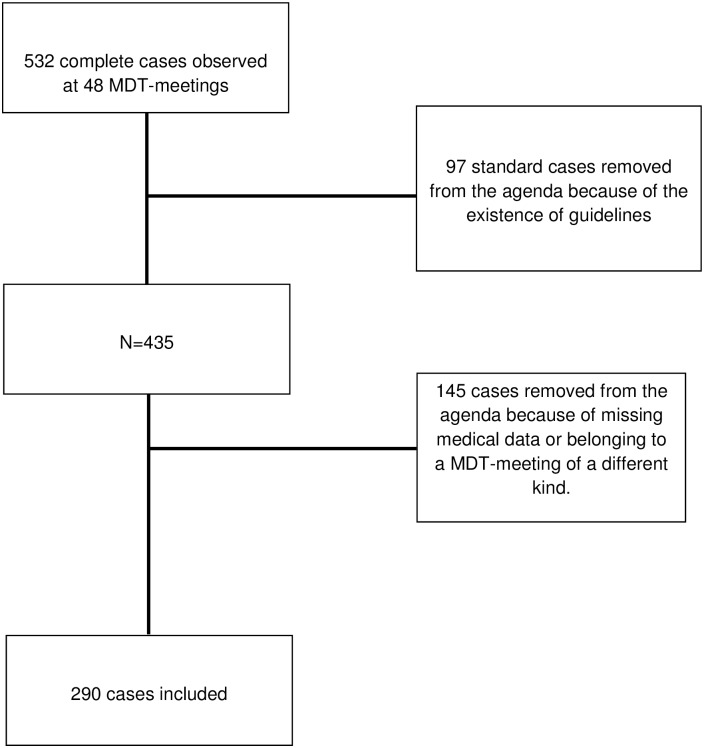
Strategy of case-records selection for the analysis.